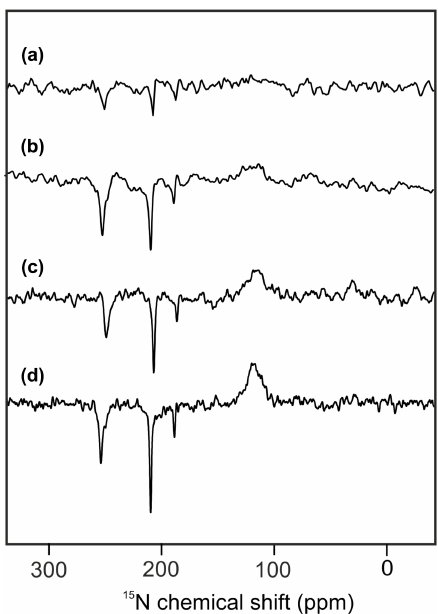
Figure 2. 15 N photo-CIDNP MAS NMR spectra obtained from the same sample of uniformly 15 N labeled PSI-110 particles of duck- weed measured at magnetic field strengths of (a) 2.35T, (b) 4.7T, (c) 7.1T, and (d) 9.4T. All spectra were obtained with a MAS fre- quency of 8kHz, a temperature of 235K, a cycle delay of 4s, and an illuminance of 320kLux provided by a white Xenon lamp. The number of scans was kept